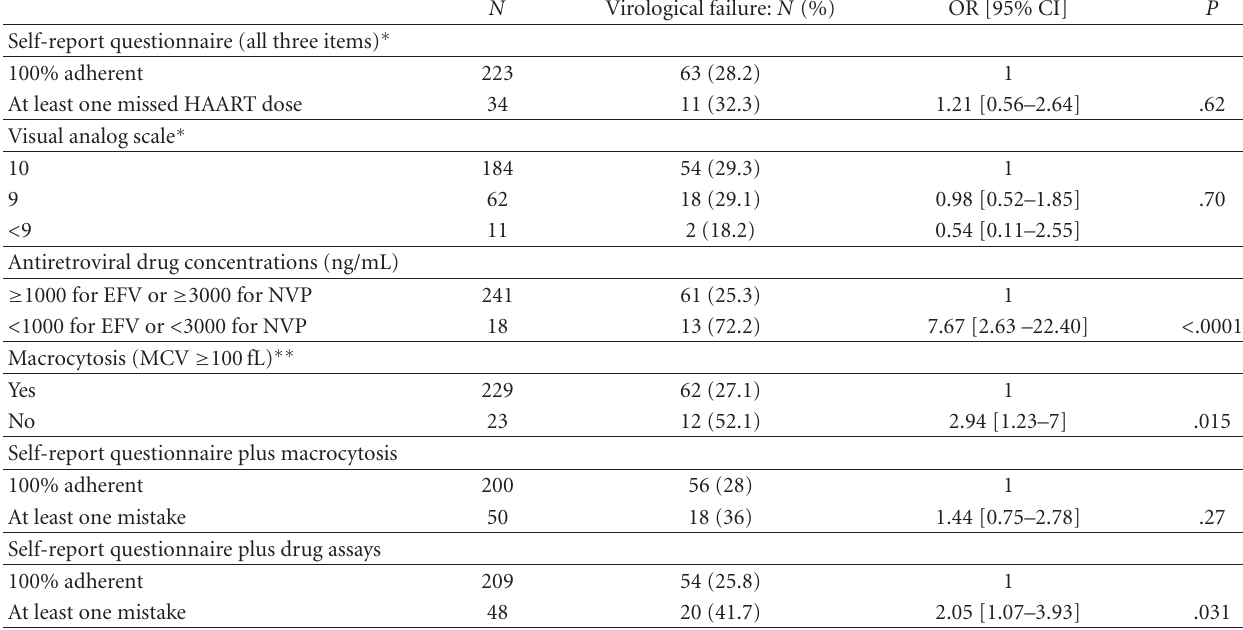
Table 2: Association between the four measures of adherence and virological failure in the overall population. N Virological failure: N (%) OR [95% CI]